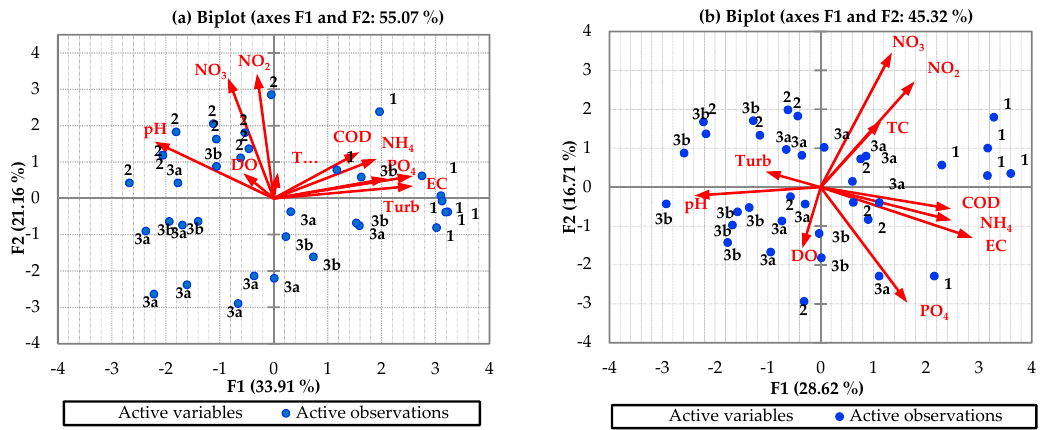
Figure 6. PC1 and PC2 loading of water parameters ( a ) in the dry season and ( b ) in the wet season. ( a ) shows a new coordinate axis in which F1 and F2 explained 33.91% and 21.16% of the total variance, respectively. The high variation of EC, Turb, pH, NO 2 − , NO 3 − were found. Cluster 1 obtained high EC, Turb, COD, and NH 4 + . ( b ) shows a new coordinate axis in which F1 and F2 explained 28.62% and 16.71% of the total variance, respectively. The concentrations of EC, NH 4 + , COD, and NO 3 − exhibited a high degree of variation in the wet season. Cluster 1 also had high EC, NH 4 + , and COD during the wet season. DO and TC exhibited low variation in both seasons.